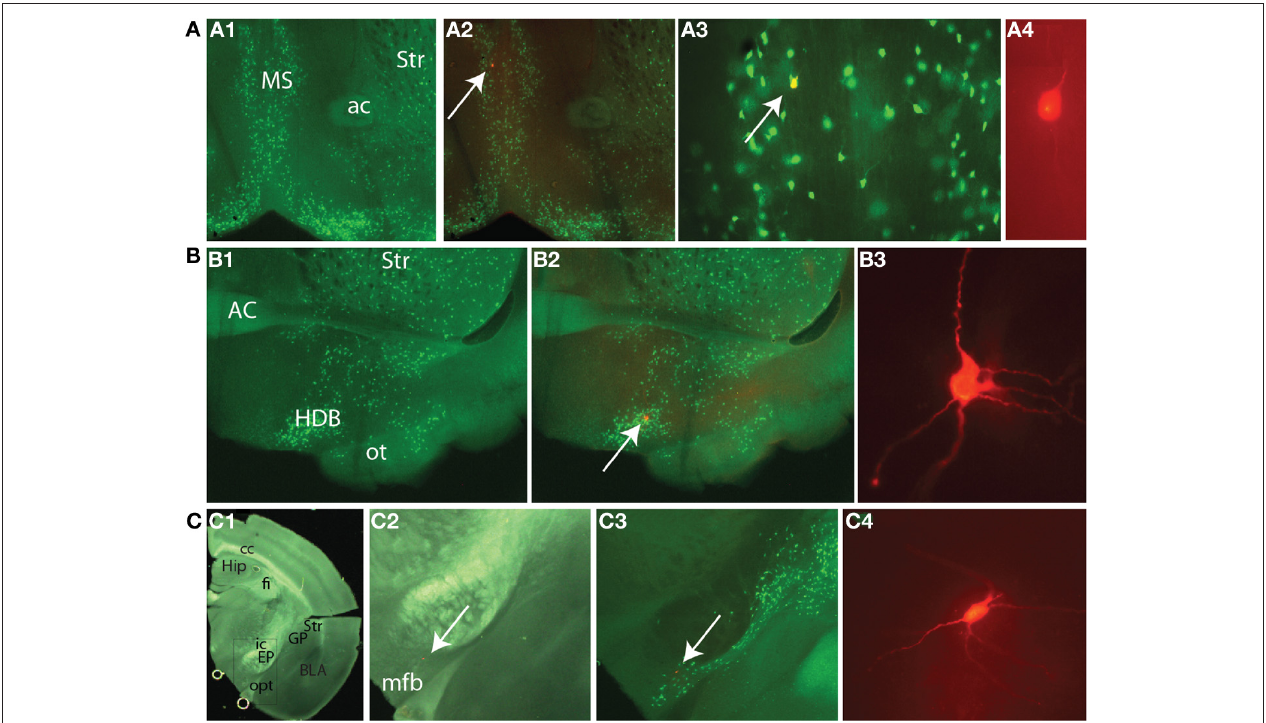
neuron. (B3) 40X image of the same cell. (C) Neurons recorded in the vicinity of medial forebrain bundle (mfb) in the most caudal extent of BF. (C1) 1.25 × image. (C2) Texas Red signal under dark field illumination taken at 4 × . The field corresponds to the box in C1 . (C3) Texas red image is overlaid with the intrinsic GFPsignal. Arrows here and in C2 point to the recorded neuron, (C4) Recorded cell at 40 × . Abbreviations: BLA, basolateral amygdala; cc, corpus callosum; EP, entopeduncular nucleus; fi, fimbria hippocampus; GP, globus pallidus; Hip, hippocampus; ic, internal capsule; opt, optic tract; Str,